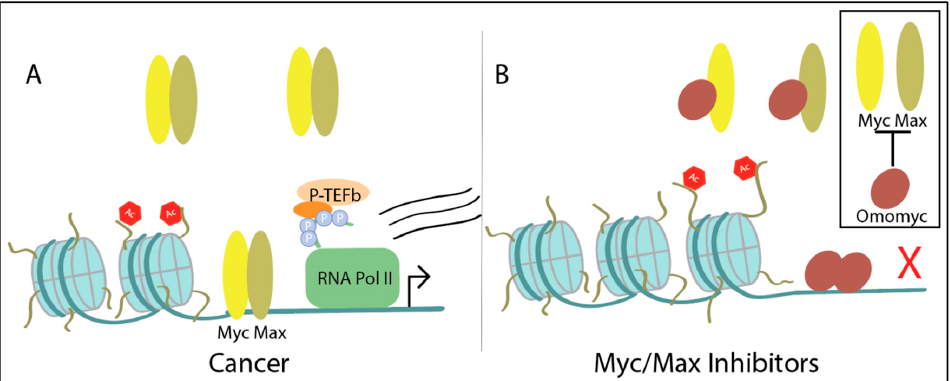
Figure 4. Heterodimerization with Max is required for Myc’s oncogenic activity: ( A ) Upon heterodimerization, Myc/Max binds to the E-box and initiates transcription. This is a normal cellular process, but in cancer, Myc amplification further increases Myc activity; ( B ) Treating with Omomyc, a dimerization inhibitor that preferentially binds to Max or homodimerizes, displaces Myc at E-boxes and decreases Myc transcription. Other discussed Myc/Max inhibitors either disrupt Myc/Max dimers or block Myc’s interaction with DNA, but not both.